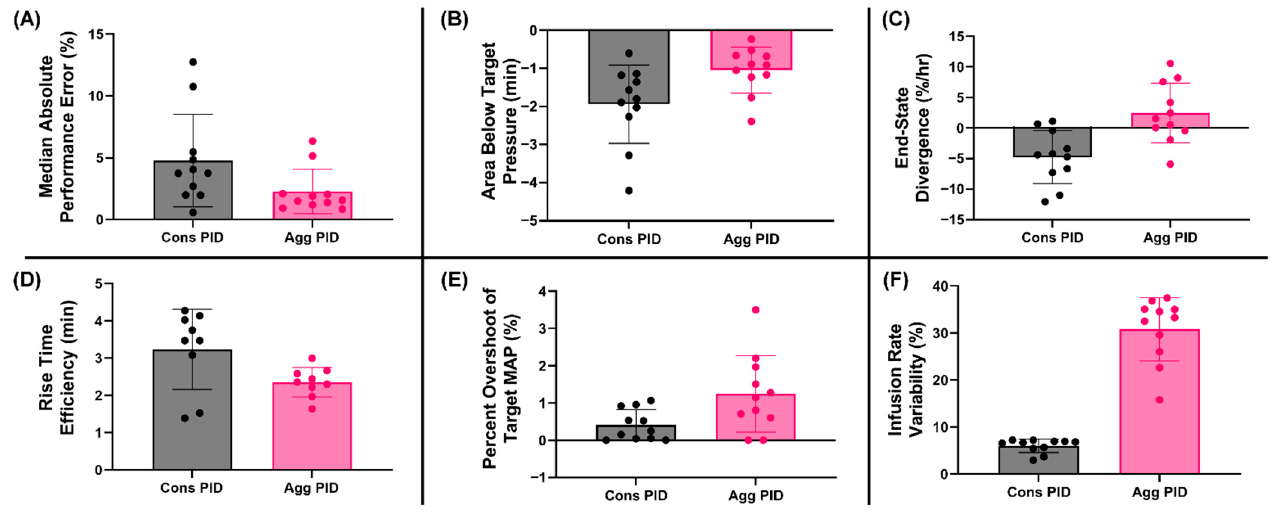
Figure 6. Summary of HATRC testing for PID tuning. Summary plots across the 11 testing scenarios for ( A ) MDAPE, ( B ) area below the target pressure, ( C ) end-state divergence, ( D ) rise time efficiency, ( E ) target overshoot and ( F ) infusion rate variability. Data points represent mean results for each scenario ( n = 11). Only 9 scenarios were included for rise time efficiency as this metric cannot be calculated for scenarios 3 and 6 where MAP started at 65mmHg.